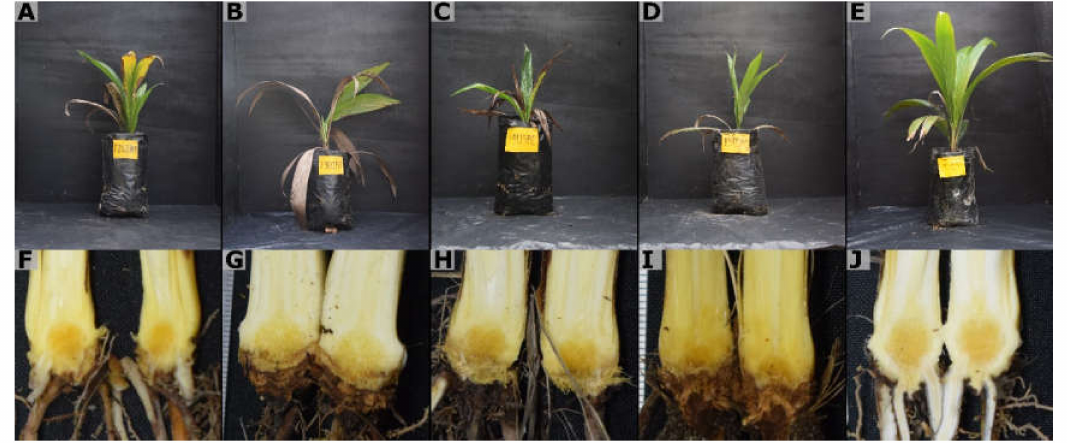
Figure 4. Oil palm seedlings exhibit external and internal symptoms. ( A – D ) Foliar symptoms in plants inoculated. ( F – I ) Bulb of the infected seedlings show brown coloration and necrosis. ( E , J ) Control (uninoculated) without signs of necrosis and healthy